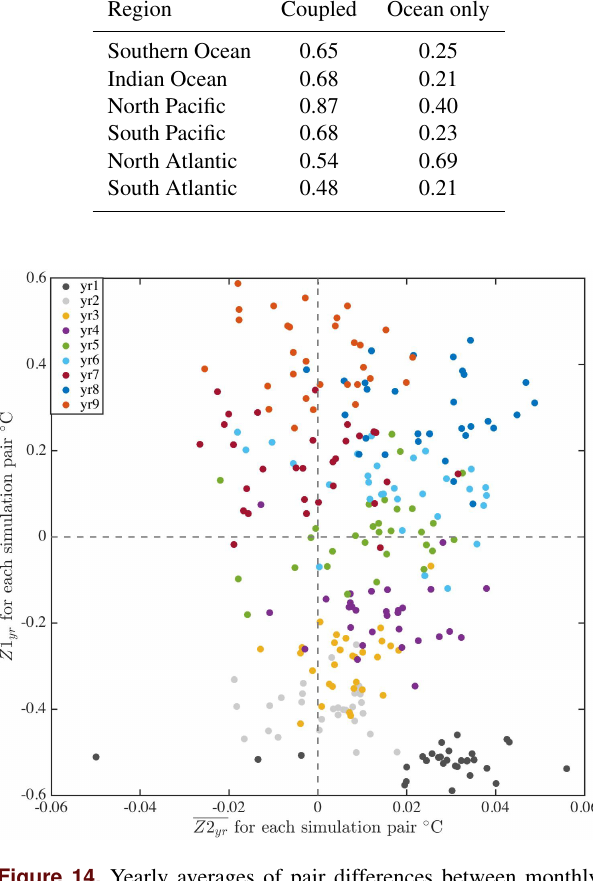
Figure 14. Yearly averages of pair differences between monthly ocean temperature derivatives Z 2 = ( X it − X it − 1 ) − ( Y it − Y it − 1 ) vs. pair differences Z 1 = X − Y , where X is the coupled simulation and Y is the ocean-only simulation. The color indicates the year, and each dot represents an ensemble pair.